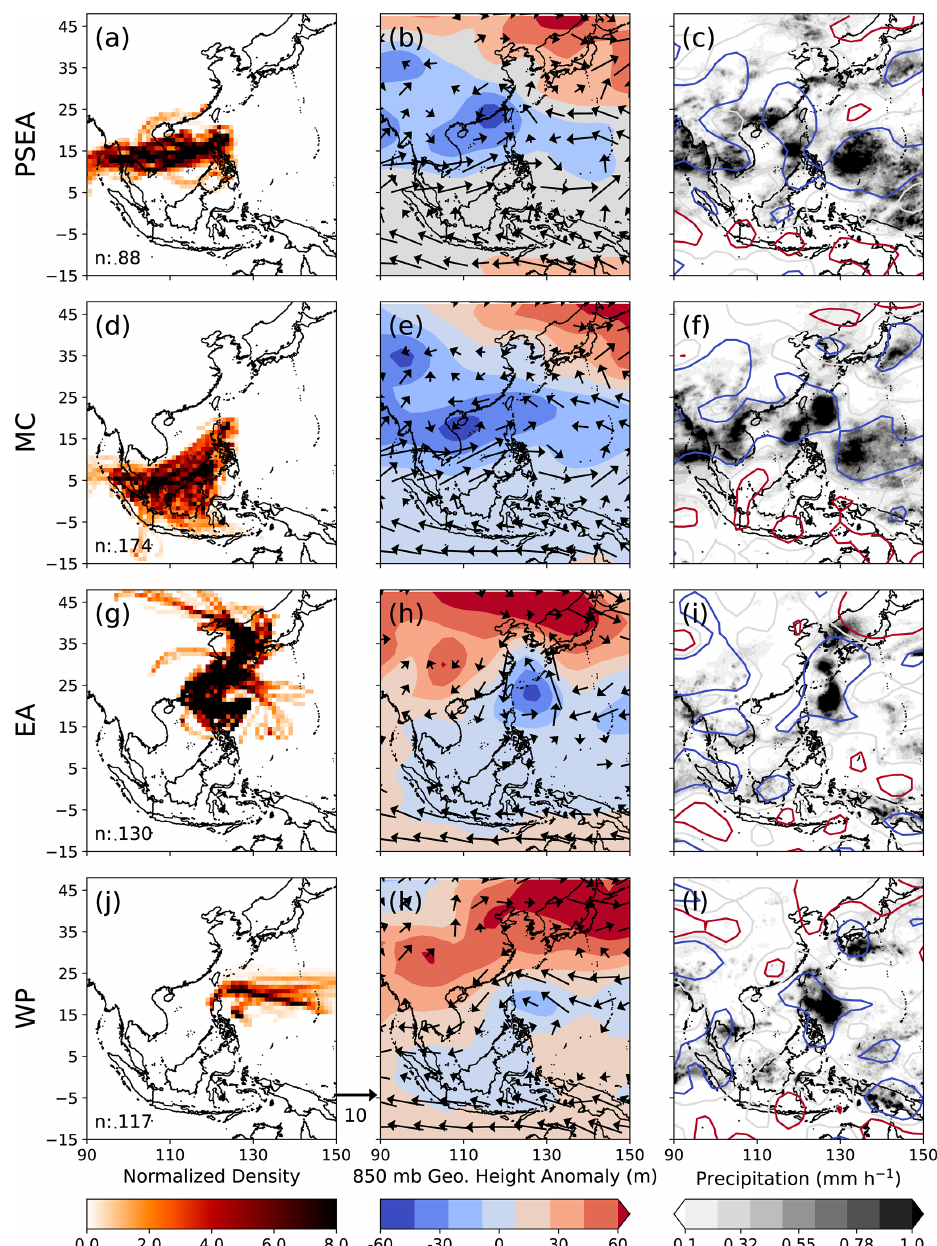
Figure 3. Classified trajectories and synoptic conditions associated with transport from (a–c) peninsular Southeast Asia (PSEA), (d–f) the Maritime Continent (MC), (g–i) East Asia (EA), and (j–l) the West Pacific (WP). Left column: trajectory density normalized to the mean per source region, with the number of trajectories classified as coming from each source region annotated on the lower left of each panel. Middle column: NCEP 850mb geopotential height anomaly from the mean for 2019, overlaid with horizontal winds ( ≥ 2ms − 1 ). Right column: PERSIANN-CDR average precipitation overlaid with NCEP 850mb ω , where red (blue) contour lines represent ω values above 0.05Pas − 1 (below − 0.05Pas − 1